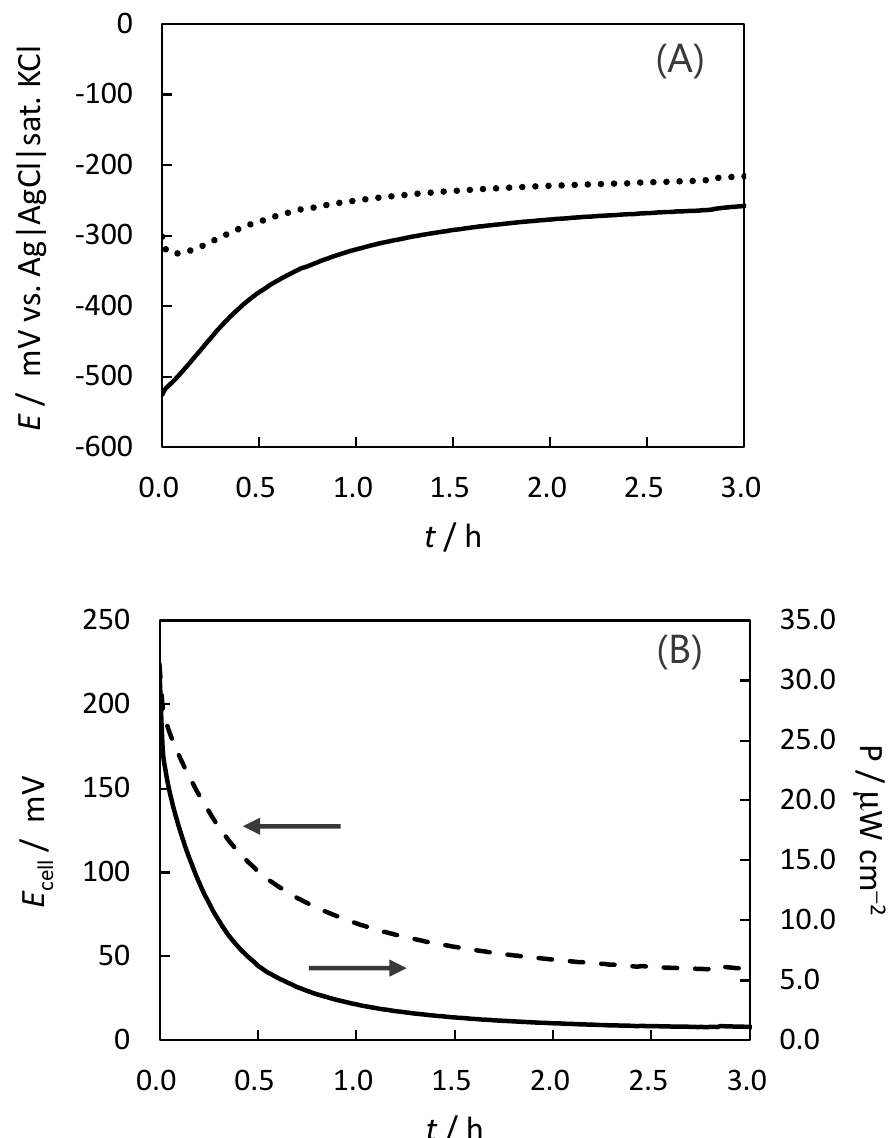
Figure 5. Continuous monitoring of the stability of the indigo-dye fermenting suspension biofuel cell under the operating conditions. ( A ) The measured potentials of the anode (solid line) and the cathode (dotted line) are plotted as a function of time. ( B ) The cell voltage (dashed line) and the power density (solid line) are plotted as a function of time. The measurements were performed in the indigo-dye fermenting suspension at room temperature under quiescent and atmospheric conditions. The load resistance was 2000 Ω .